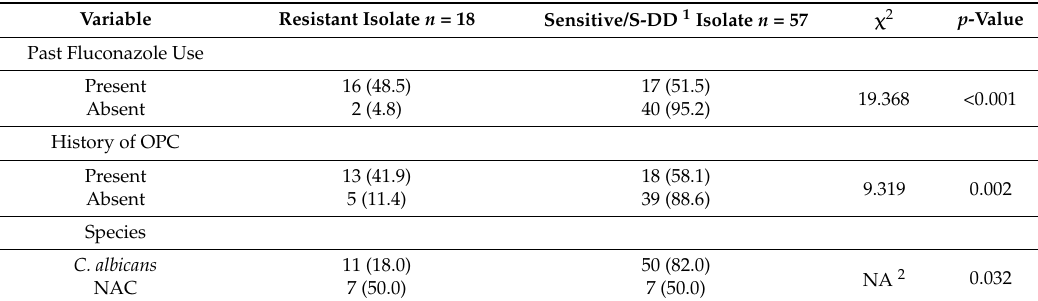
Table 2. Factors associated with fluconazole resistant isolates in PLWHA.